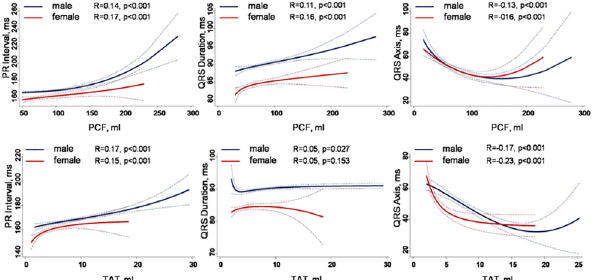
Fig 2. The associations between PCF or TAT on several electrocardiographic indices, including PR interval, QRS duration and QRS axes. No sex interactions were observed n these associations.